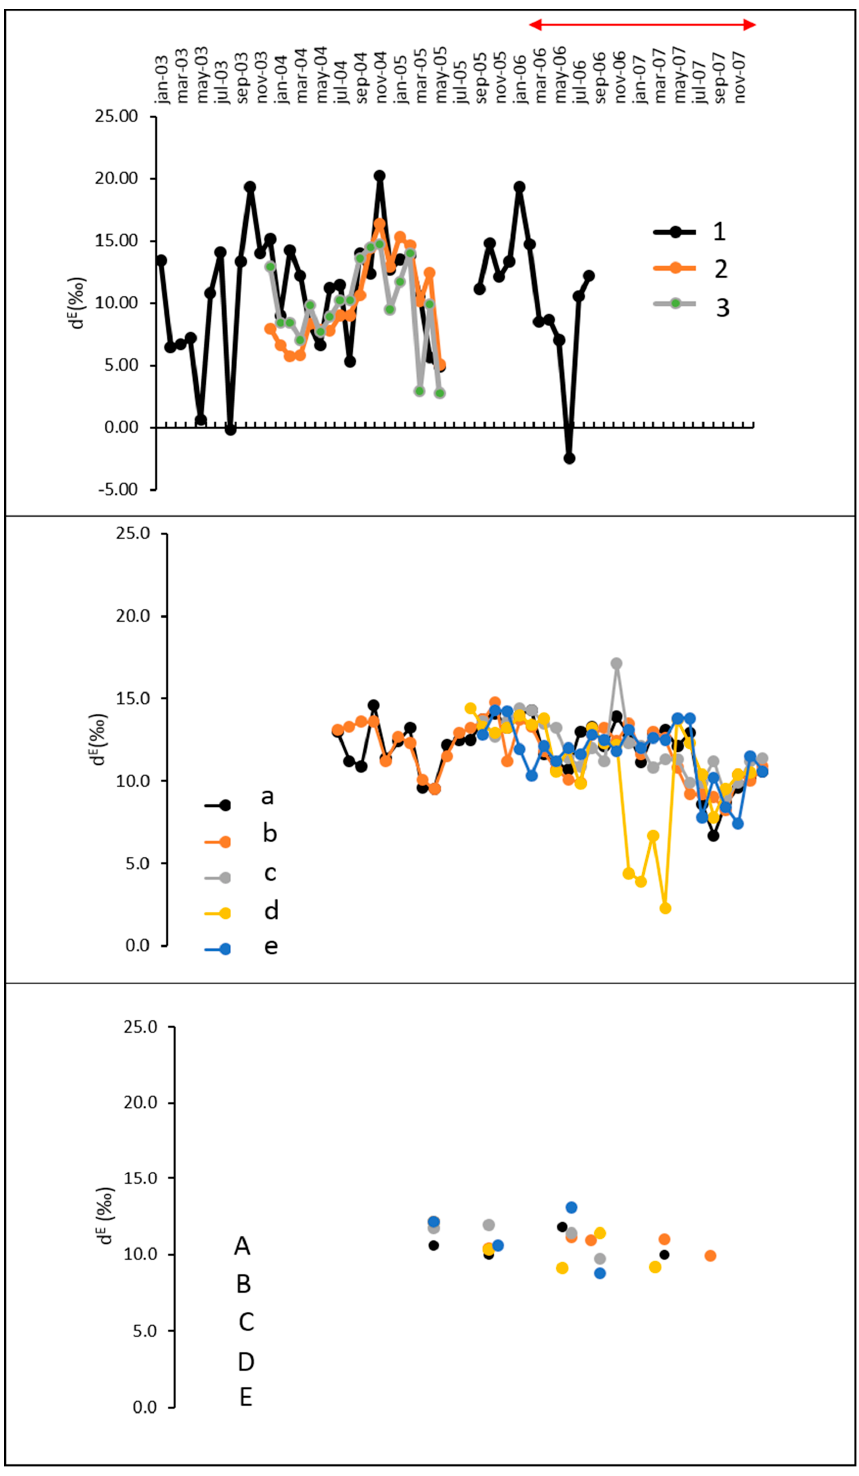
Figure 5. Pattern of d E in precipitations (above), surface water (central) and groundwater (below) from the apical parts of alluvial fans. Letters from a to e and numbers from 1 to 3 recall surface water and precipitation, respectively. Capital letters from A to E refer to groundwater from the apex part of each alluvial fan (in form of aggregated isotopic values from all the wells). The red bar indicates the time period (from January 2005 to December 2007) over which the statistical analyses on surface water and groundwater were carried